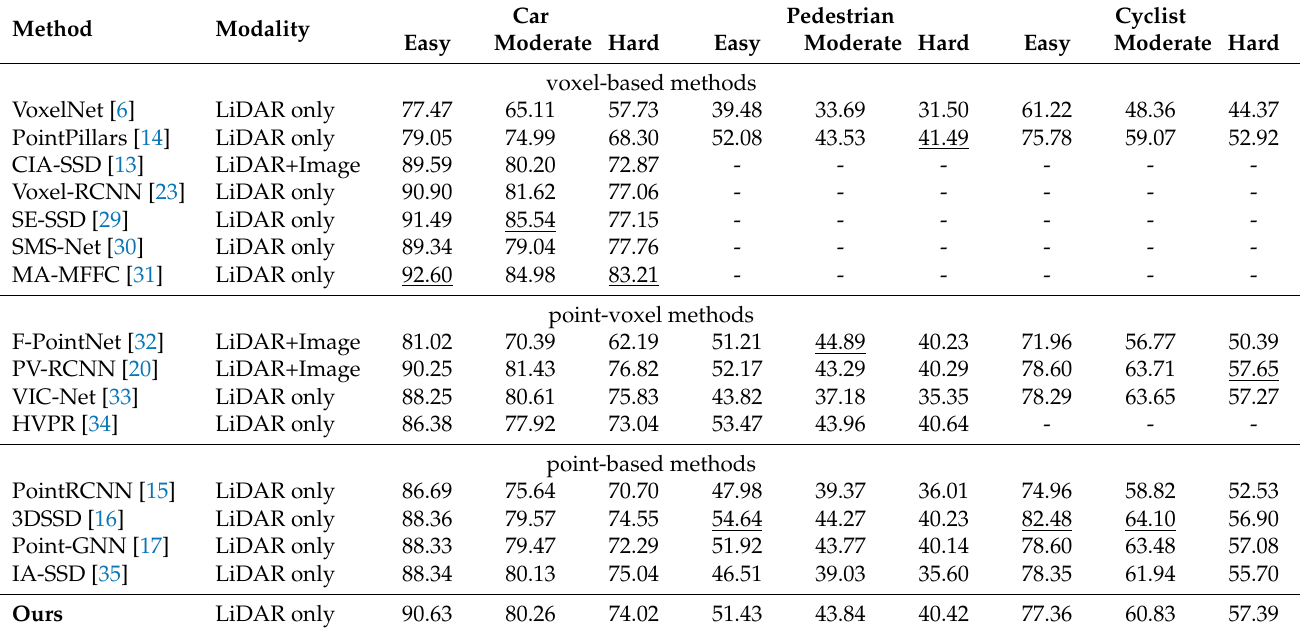
Table 1. The performance of 3D object detection AP 3 D